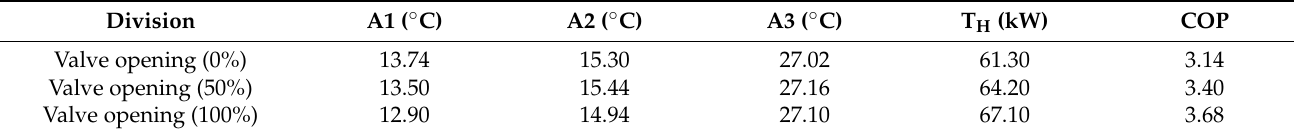
Figure 9. Average COP results for the air and refrigerant sides for different valve openings. Table 22. Average data of five experiments based on the air